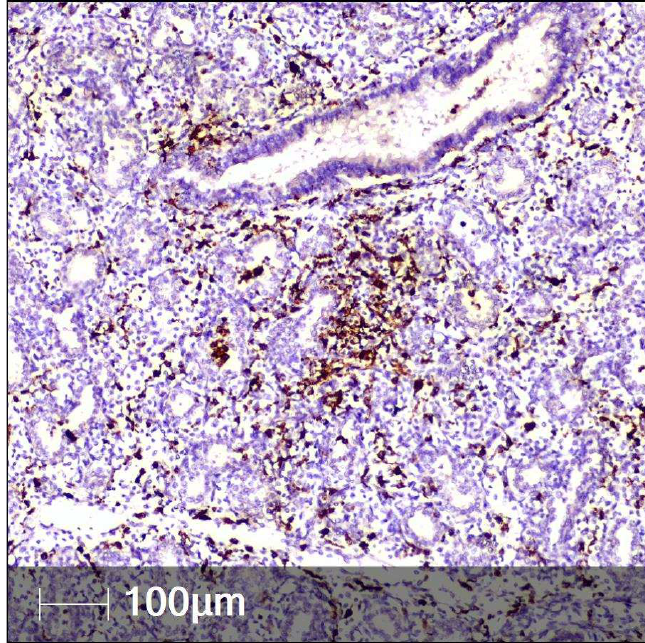
Figure 7. CD68-positive macrophages in fetal lung tissue (IHC).